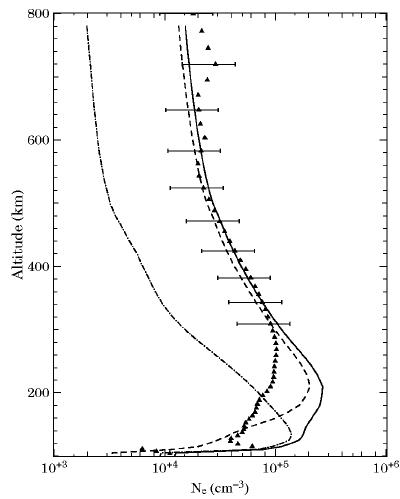
Fig. 9. Contribution of precipitating electrons (dash line) as a single source in the code and of proton precipitation (dash-dotted line) as a single source in the code to the total electron density (black solid line). The model’s outputs are drawn versus the ESR averaged mea- sured electron densities, which are indicated with black